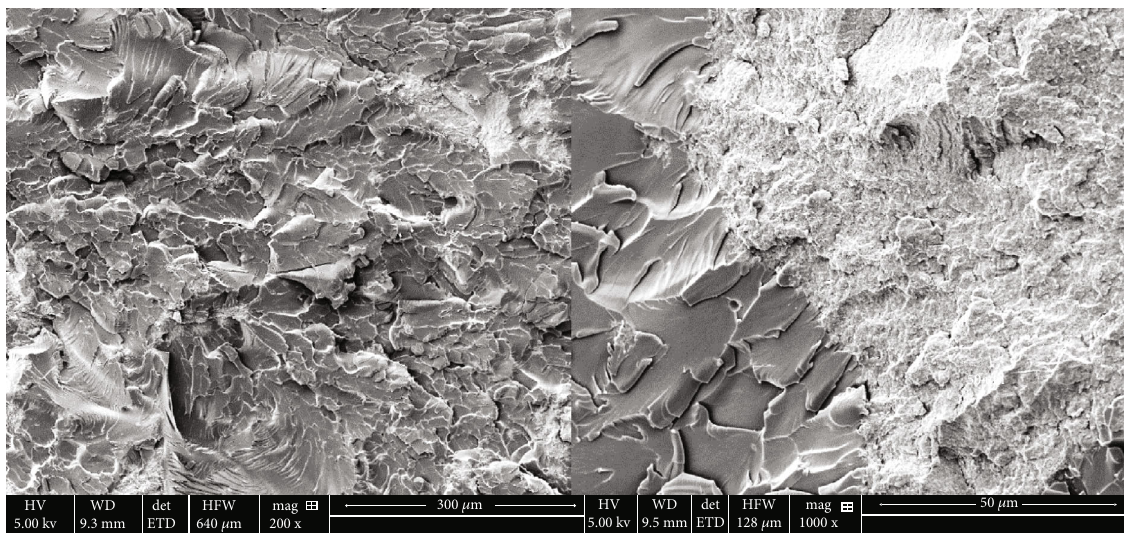
Figure 18: Fracture surfaces due to tensile failure in a 1.5wt.% MWCNT-reinforced epoxy composite subjected to 1500 thermal